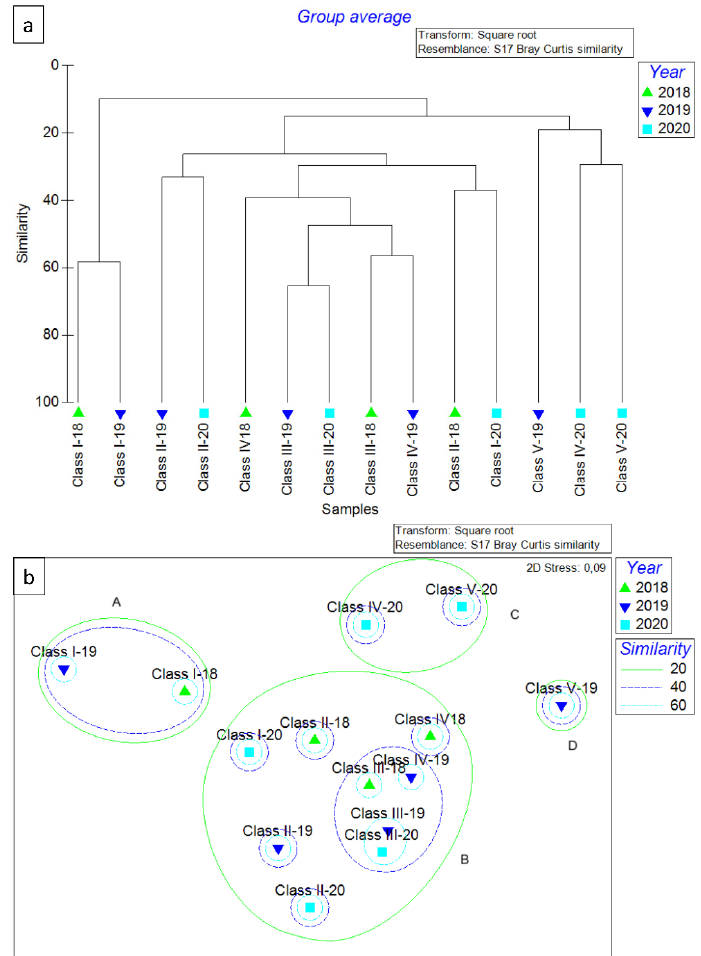
Figure 11. Dendrogram ( a ) and MDS ordination of Bray–Curtis similarities ( b ) from dietary data (square root transformation) for the all hake classes analyzed in 2018–2020. Cluster A included the specimens belonging to Class I collected during 2018 and 2019. Cluster B grouped the specimens belonging to Class I collected during 2020, and Classes II–IV of all three years, except for Class IV samples collected during 2020. Cluster C included Classes IV and V from 2020. Finally, Cluster D only included specimens belonging to Class V from 2019.